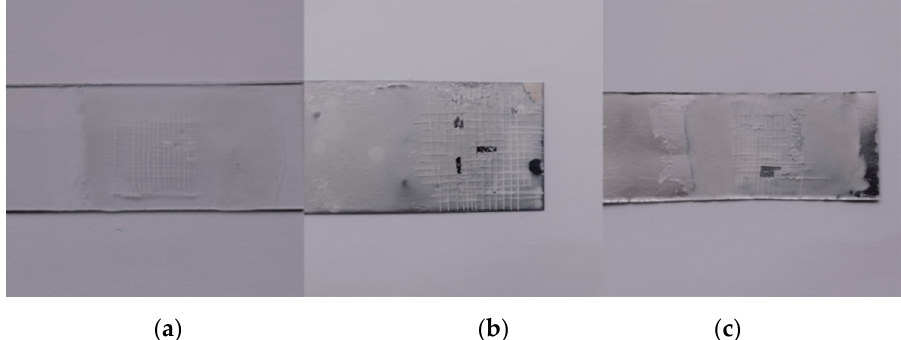
Figure 4. The photos for the adhesive experiments of the coatings on various substrates. ( a ) Glass slide; ( b ) tin plate; ( c ) aluminum sheet.